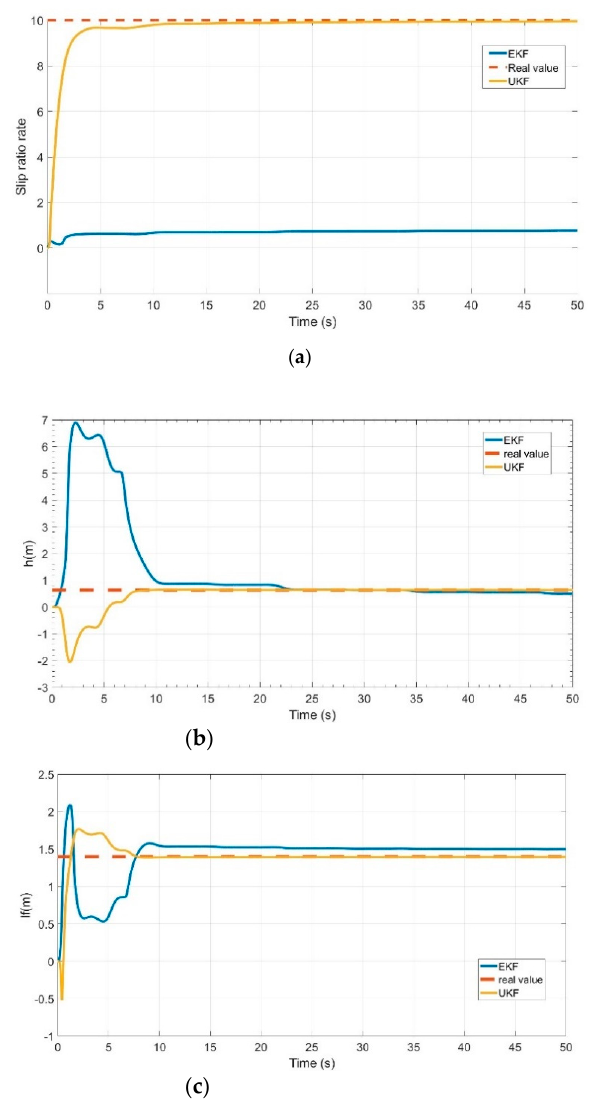
Figure 5. First stage VDPs estimation: ( a ) slip ratio rate estimation; ( b ) the height of vehicle centroid estimation; ( c ) estimation of the distance between the vehicle centroid and vehicle front